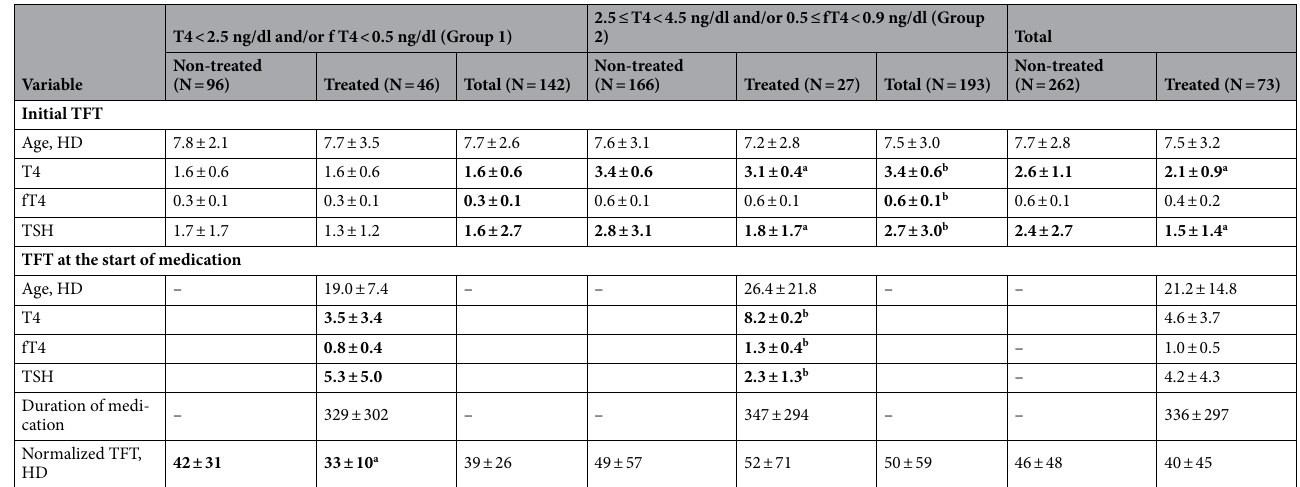
Table 2. Thyroid function test data of infants with transient hypothyroxinemia of prematurity. Values are presented as means ± SD. Significant values are in [bold]. T4 thyroxine, fT4 free thyroxine, TFT thyroid function test, HD hospital day, TSH thyroid-stimulating hormone. a p < 0.05 compared with non-tereated group. b p < 0.05 compared with group 1. T4 and fT4 as µg/dl, TSH as